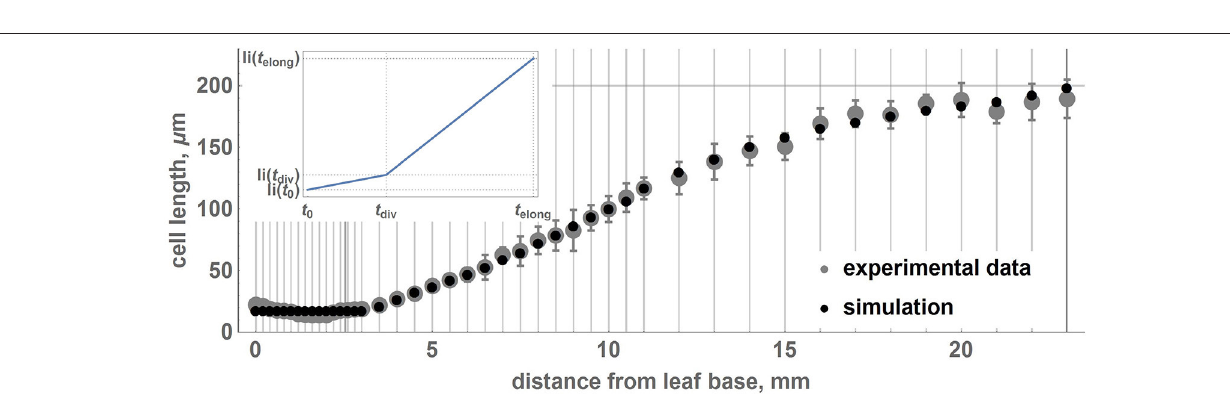
FIGURE 3 | Relationship between average lengths of cells and distance from the leaf base: comparison between experimental data and the model. Points correspond to the average lengths of the cells on intervals designated by gray vertical lines. Gray points denote experimental data, and black points denote the results of the simulation with the obtained optimal parameters. The error bars denote the standard errors of the mean. The experimental points and standard errors were obtained by manual digitizing of data on leaf 1 from Beemster et al. (1996). The inset shows a piecewise linear growth function for the isosmotic length of the